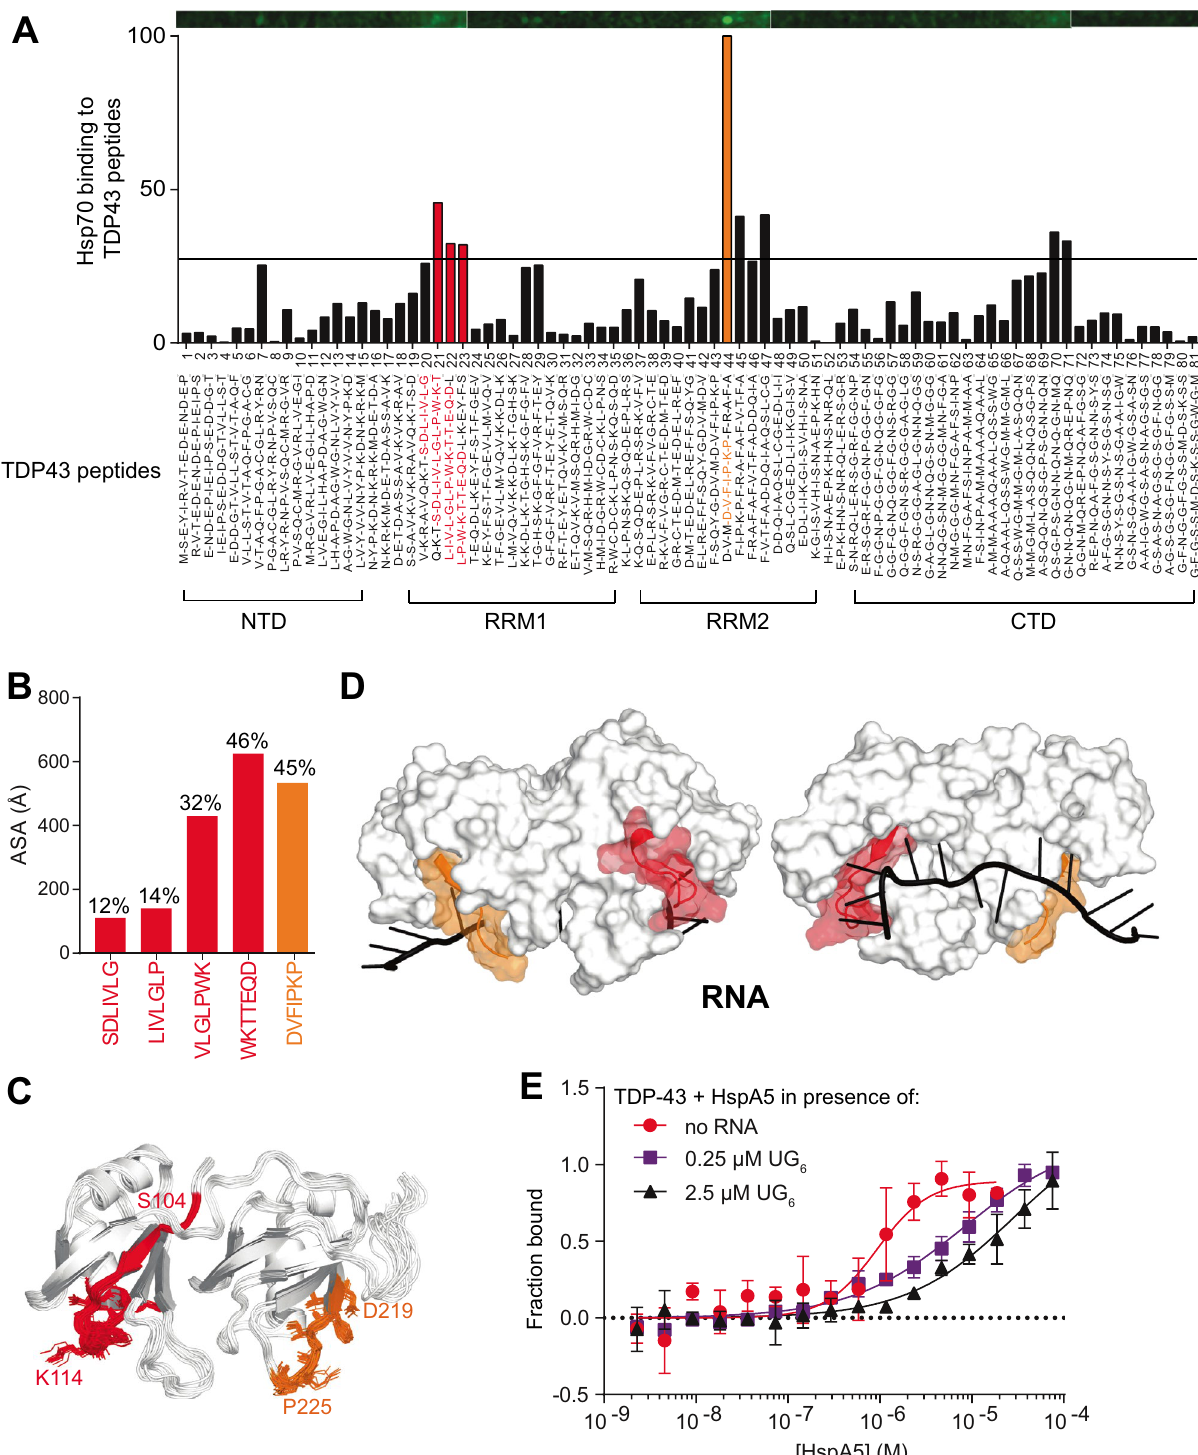
Figure 3. Mapping of the Hsp70 client peptides to the RRM and RNA-binding interface of TDP-43. ( A ) Binding of HspA5 on immobilized 15-mer TDP-43 peptides, in overlapping five amino acid steps. The blots were scanned, and spot intensities were quantified and represented as a normalized signal. Highly scored LIMBO predicted client peptides of TDP-43 are shown in red and orange, respectively. ( B ) Accessibility of the client peptides from the peptide array at the TDP-43 surface (ASA) were calculated using Areaimol as implemented in the CCP4 suite 35 on the free form structure of the tethered RRM domains (PDB ID 4bs2 22 ). To note, there is no significant difference in accessibility values when RNA is present. The percentage of accessibility represents the ASA of the motif compared to the total surface of TDP-43. ( C,D ) Mapping of the client peptides on TDP-43 or NMR structures (cartoon representation) ( C ) or surface ( D ) of the RRM domain (PDB code: 4bs2 22 ). The predicted client peptides were color coded as described in ( A ). ( E ) Microscale thermophoresis of NTA-labelled TDP-43 102–269 interaction with HspA5 in the absence or in the presence of increasing concentrations of UG 6 RNA. The presence of RNA shifted the Kd of the TDP-43 102–269 /HspA5 interaction from 0.89 ± 0.25 µM ( red curve) to 28.3 ± 23.7 µM ( black curve). Data is presented as Mean ± SD (n =